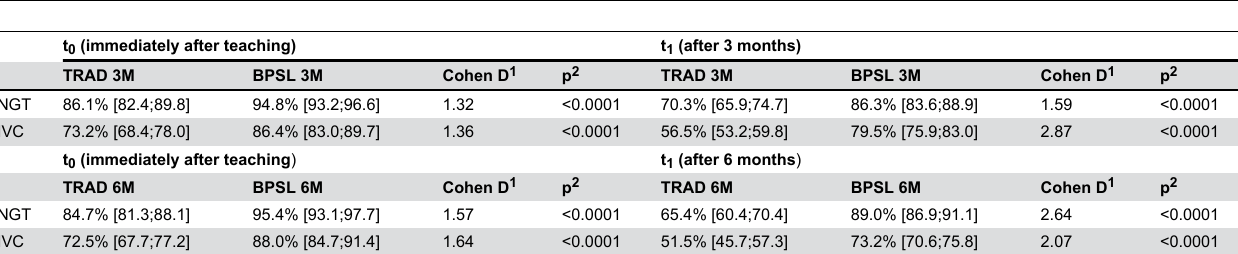
Table 2. Percentages of maximal achievable points with the 95%CI provided in squared brackets on binary checklist (NGT = 26 points, IVC = 29